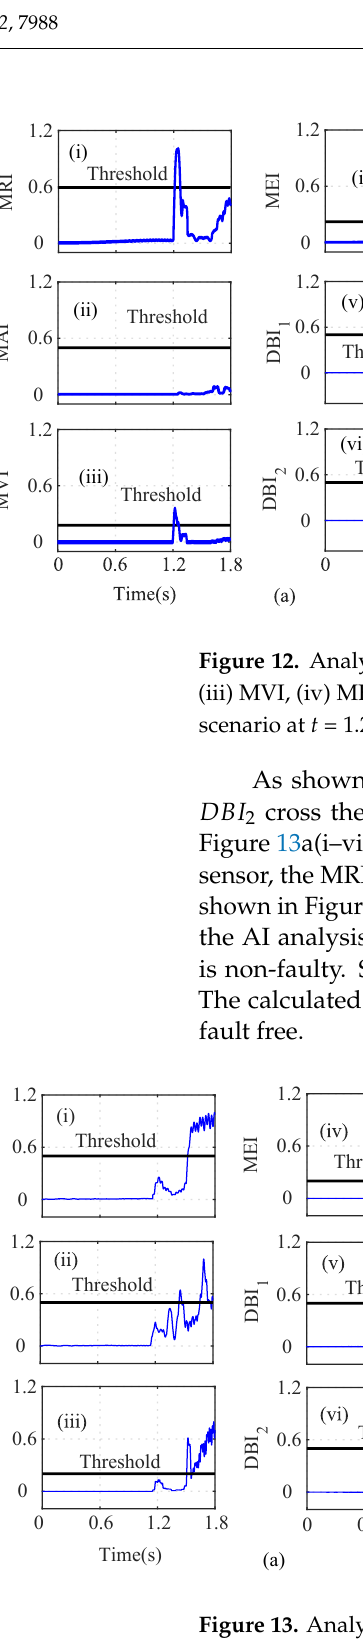
Figure 13. Analysis of residuals for ( a ) ω e and ( b ) E α using index-based method ((i) MRI, (ii) MAI, (iii) MVI, (iv) MEI, (v) DBI 1 and (vi) DBI 2 ) for the 20% noisy incipient i α fault and abrupt ω e fault scenario at t = 1.25 s and t = 1.50 s,